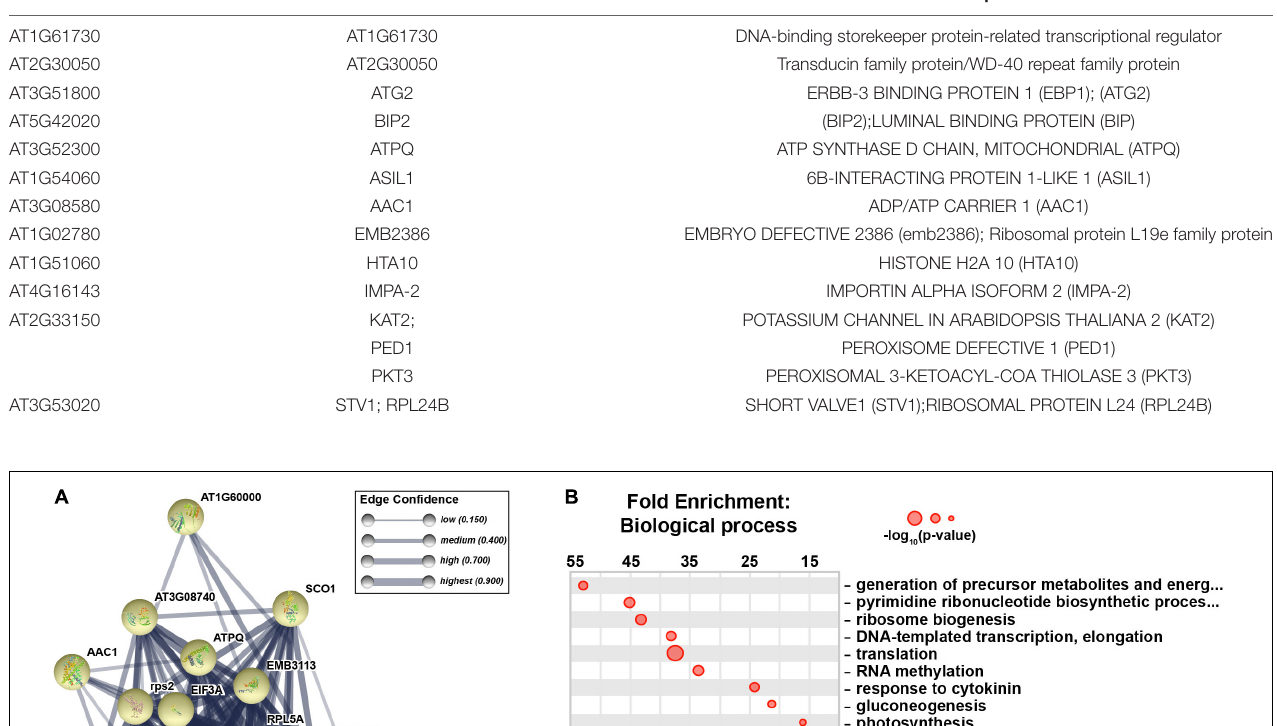
TABLE 4 | Nucleolar lncCOBRA1-interacting proteins. Locus Description